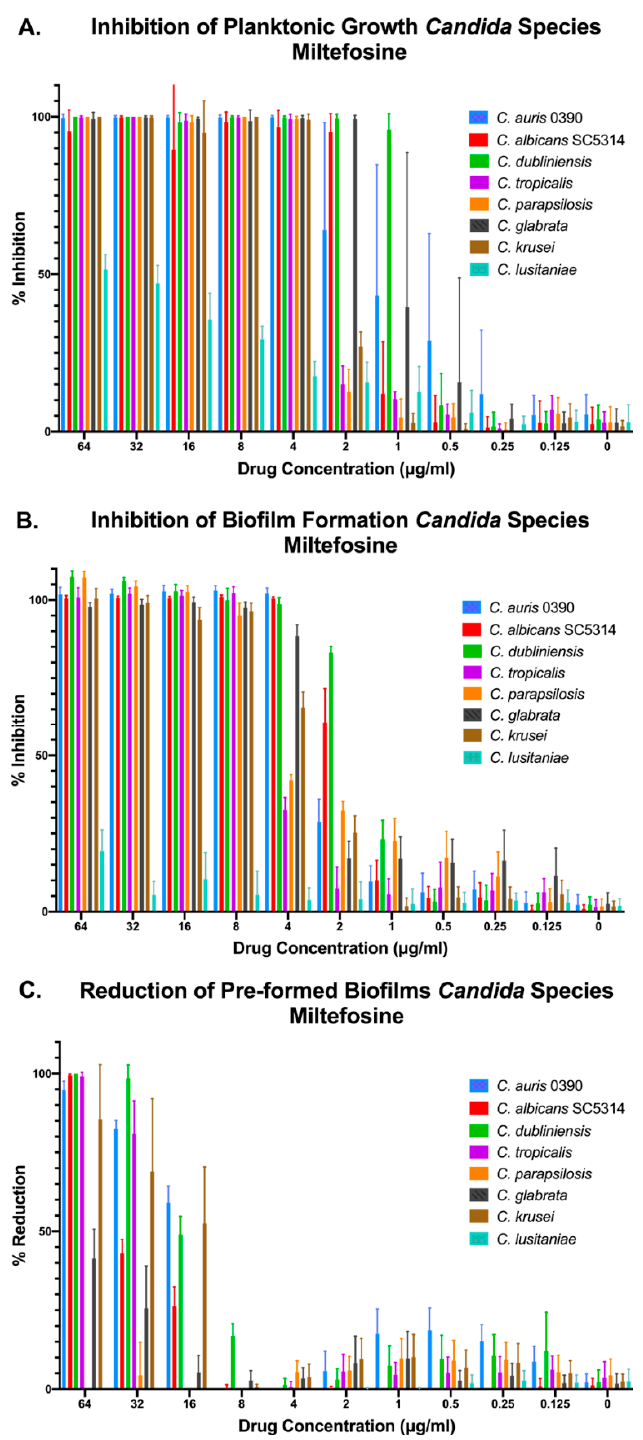
Figure 4. Activity of miltefosine against representative strains from different Candida spp. under the three different growing conditions: inhibition of planktonic growth ( A ), inhibition of biofilm formation ( B ), and activity against preformed biofilms ( C ) .